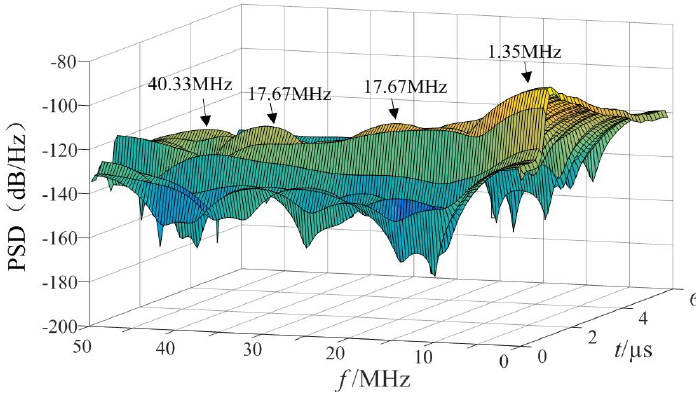
Figure 12. Power spectrum of simulated magnetic field intensity (1 mm).